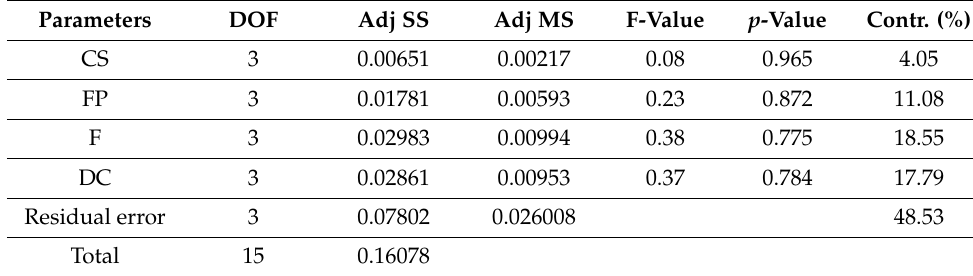
Figure 3. Grey relational grade graph of factors. Table 6. Grey Relational Grade (GRG) results by